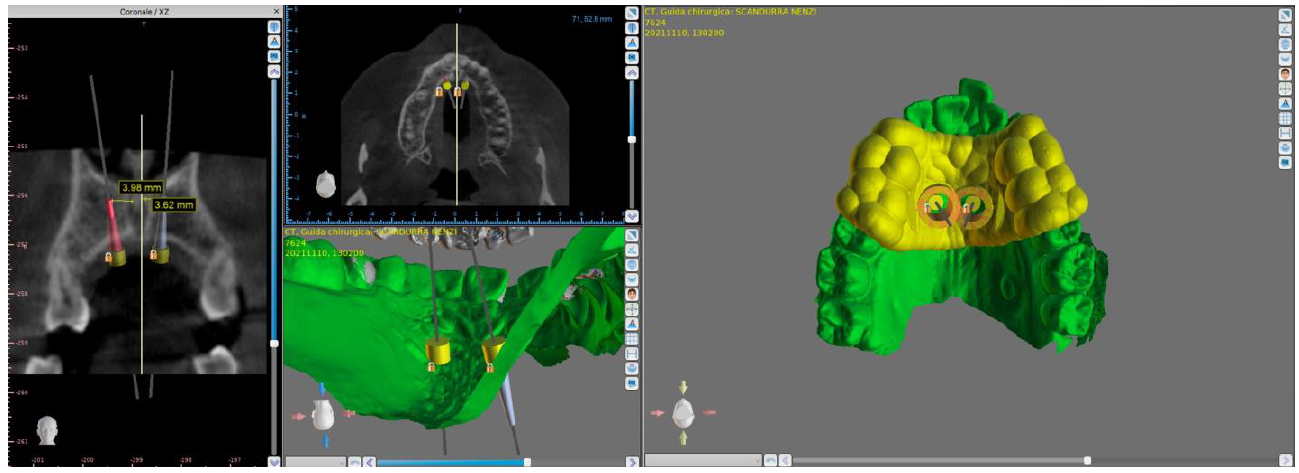
Figure 13. Example of digitally assisted miniscrew insertion system using free-source software (BlueSkyPlan v. 4.9.4).